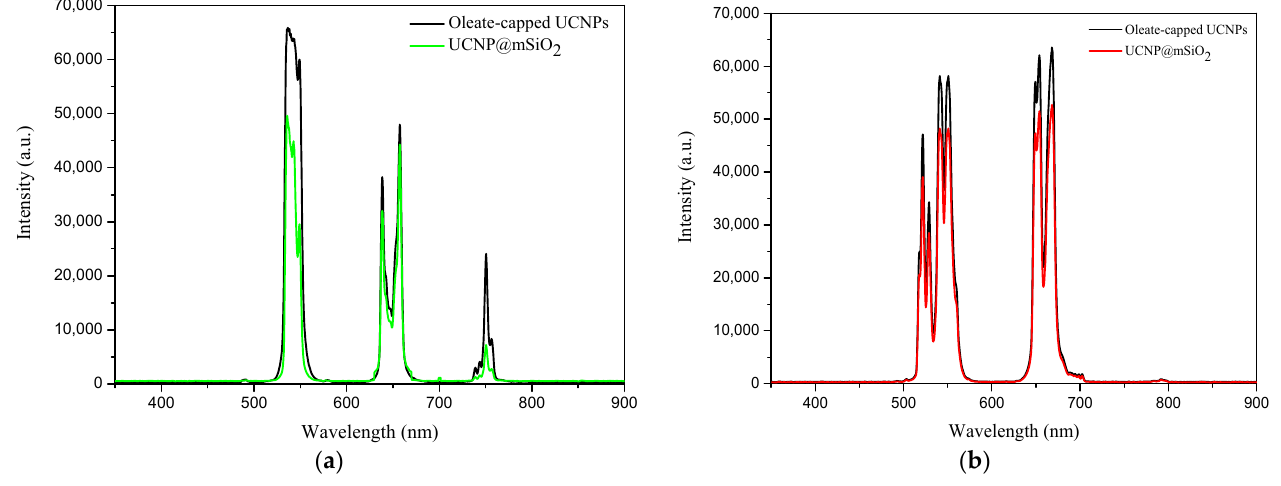
Figure 5. PL spectra of ( a ) oleate-capped and mSiO 2 -coated LiYF 4 : Yb 3+0.25 /Ho 3+0.01 @ LiYF 4 :Yb 3+0.2 and ( b ) oleate-capped and mSiO 2 -coated LiYF 4 : Yb 3+0.25 /Er 3+0.01 @ LiYF 4 :Yb 3+0.2 UCNPs under 980 nm NIR irradiation.